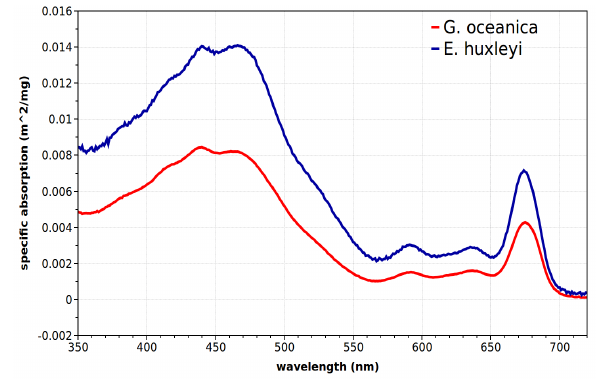
Fig. 6. Specific absorption spectra of two different coccolithophore species obtained from cultures: G. oceanica (red), isolated from the North Atlantic near the Portuguese coast; and E. huxleyi , isolated from the Tasman Sea in the South-west Pacific.